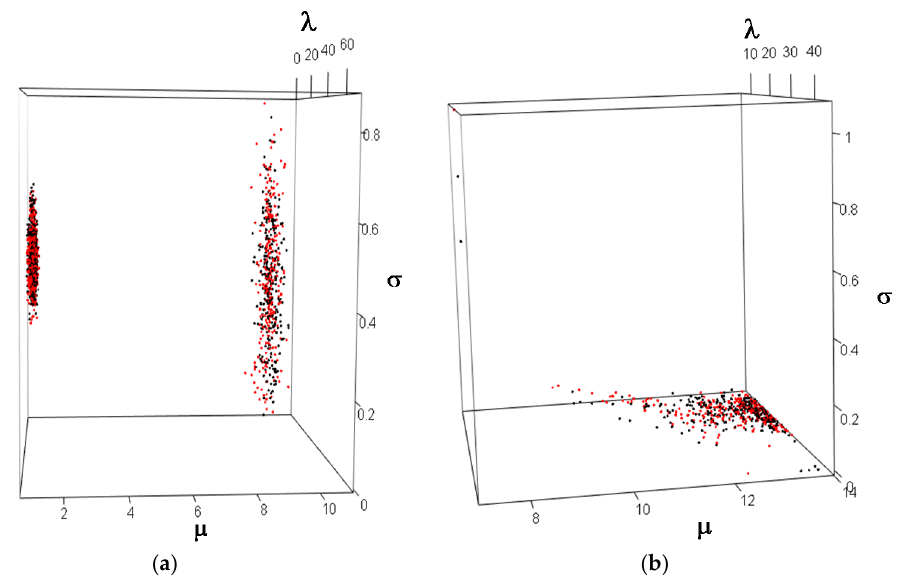
Figure 6. CPFS results: ( a ) the left panel shows the Gaussian mixture copula model (GMCM) analysis for Scenario (IV); ( b ) the right panel shows a Gaussian copula analysis for the chemical spills data; red points indicate copula fit, while black are actual data. For both simulated and real-world data, the CPFS method closely fits the real data to the copula function.